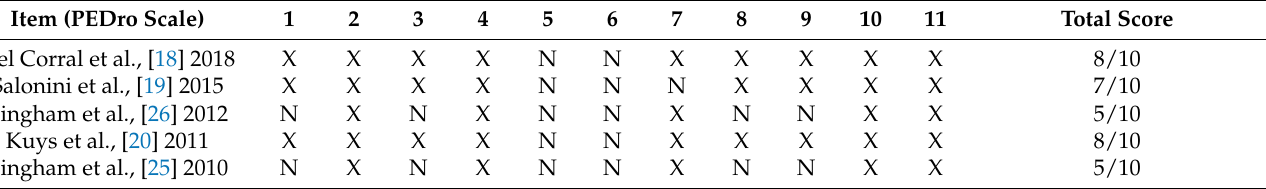
Table 3. The results of the methodological quality of the studies were determined using the PEDro